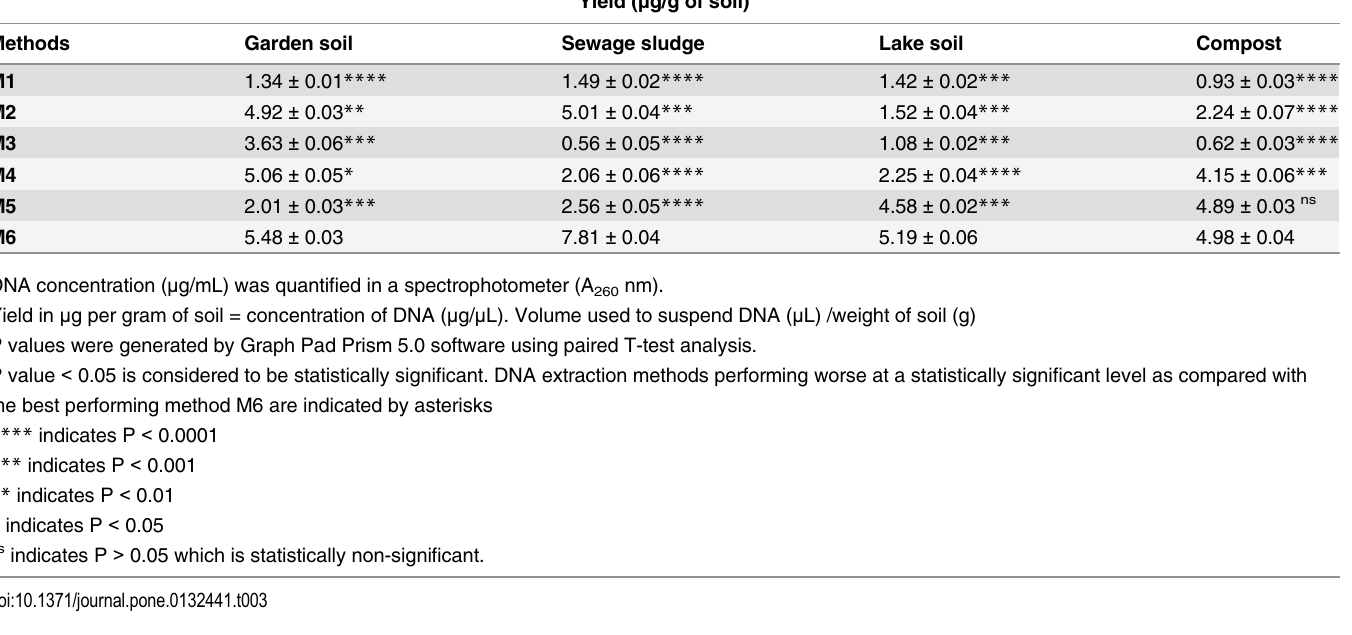
S5 Fig and S6 Table. The average yield of DNA using glass beads was 2.1 ± 0.08 μ g/g of soil; much lower than glass powder (5 ± 0.11 μ g/g of soil). The addition of PAC to the glass powder did not adversely affect the DNA yield with an average yield of 5.4 ± 0.04 μ g/g for the four soil types analyzed. In addition, the purity obtained by the use of glass powder combined with PAC was higher when compared to the use of glass beads or glass powder alone.